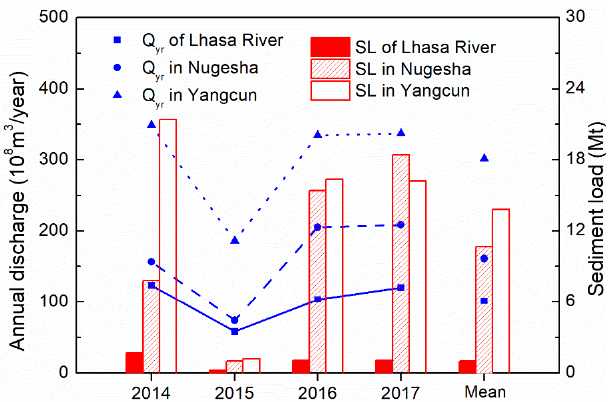
Figure 8. Contributions of the Lhasa Rive to annual discharge and sediment load.